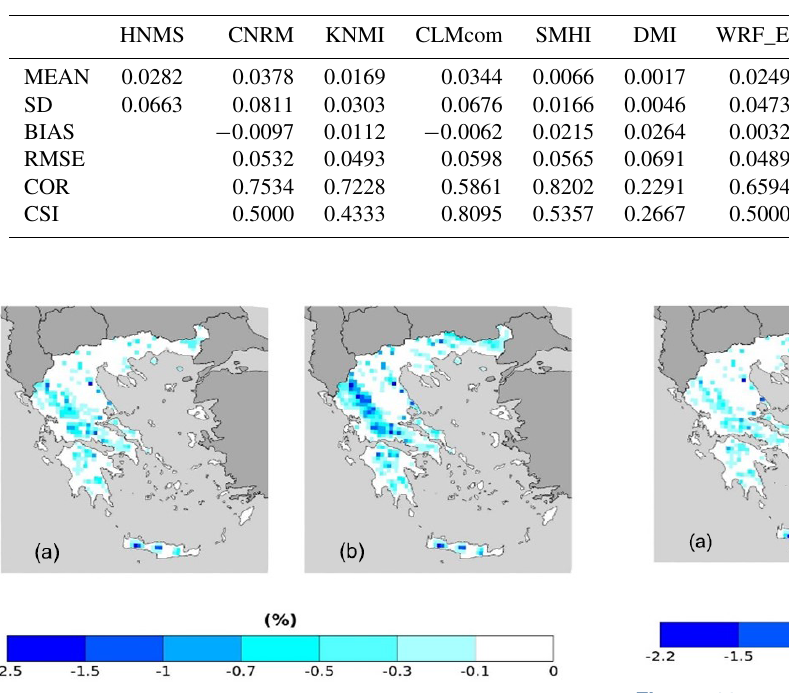
Table 7. Table exhibiting mean (MEAN) RR20ID copula probabilities station probabilities (%) for observations and models, standard deviation (SD), bias (BIAS), rmse (RMSE), Pearson correlation (COR), and CSI of models against observations.